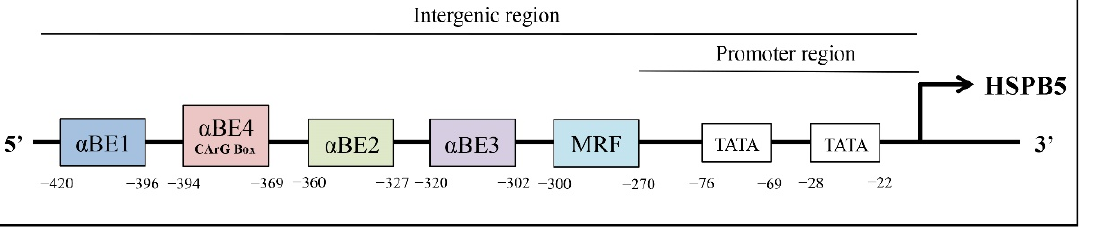
Figure 2. Characterization of HSPB5 upstream enhancers required for the activity of sHSPs. Exon, BE: alpha binding element, MRF: muscle regulatory factor; TATA box. These cis -elements localized in the intergenic region of HSPB5 contain the DNA-binding sites or protein binding complexes by which known transcription factors (e.g., AP1, CREB, RORA, AP2F, PAX3) regulate sHSP expression.